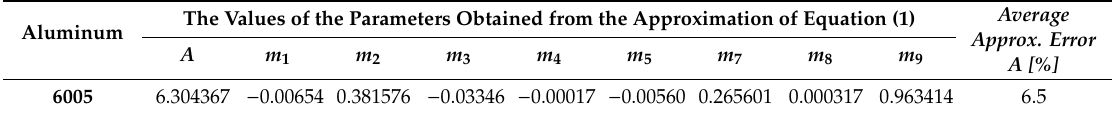
Figure 4. Work-hardening curves for the strain rate range of (0.1 s − 1 –10.0 s − 1 ) at temperature of: a ) 150 °C; b ) 200 °C; c ) 250 °C; d ) 300 °C; and e ) 350 °C. (Black indicates the experimental curves; red indicates the approximated curves). Table 4. Values of the parameters A and m 1 – m 9 used for determining the value of σ p for aluminum alloy